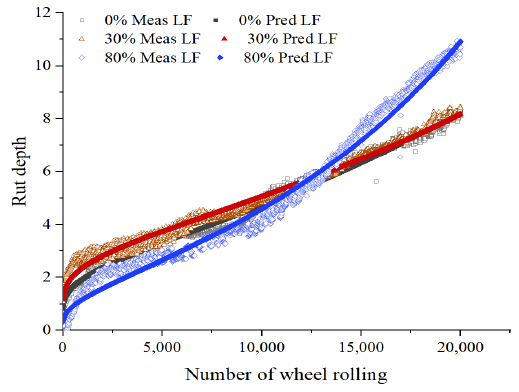
Figure 18. HWTT curve of LF asphalt mixture.